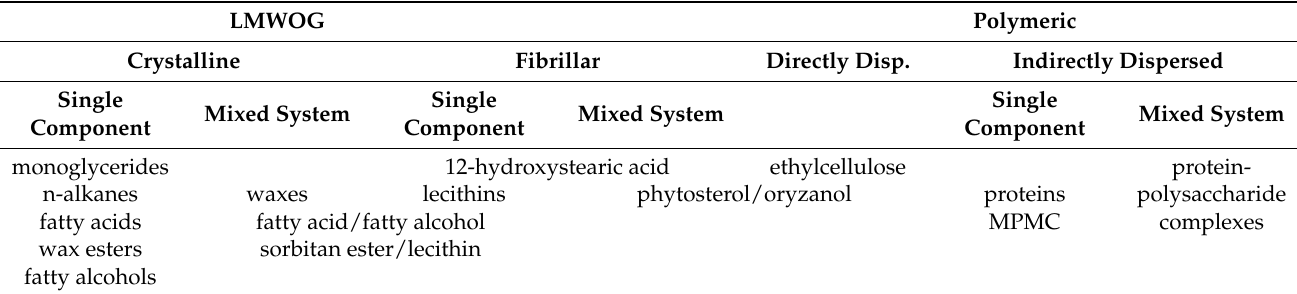
Table 1. Categorization of oil structurants. Low molecular weight oleogelators (LMWOG) appear in either crystalline or fibrillar structures. Polymeric oleogels can be distinguished based in the dispersion